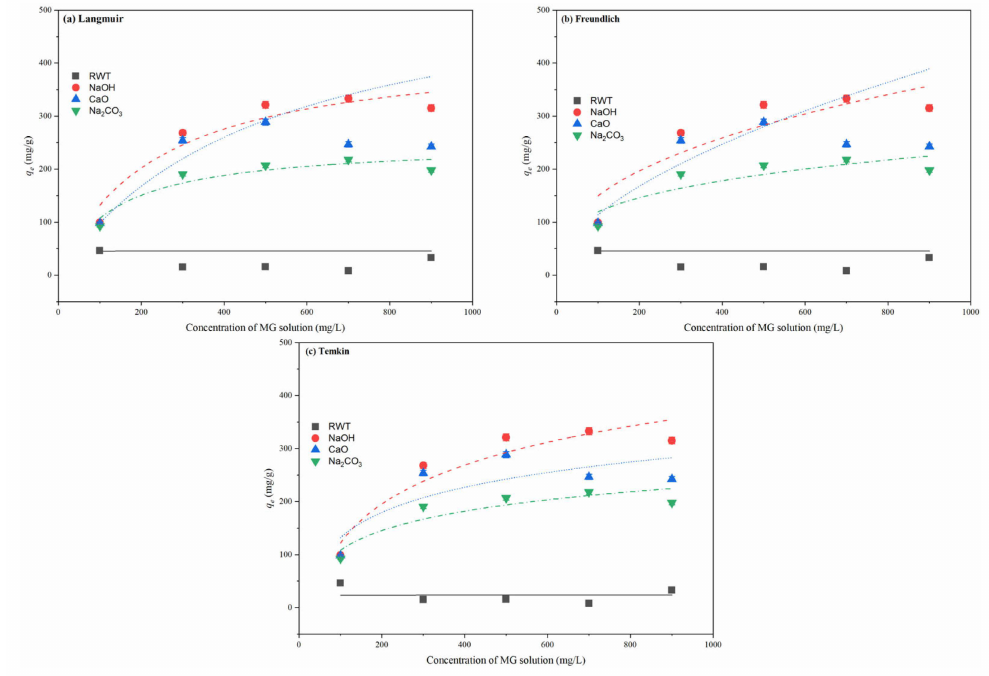
Figure 11. Adsorption isotherm fitting curves for MG sorption on PCs derived from waste tires (Dosage = 40 mg and T = 301